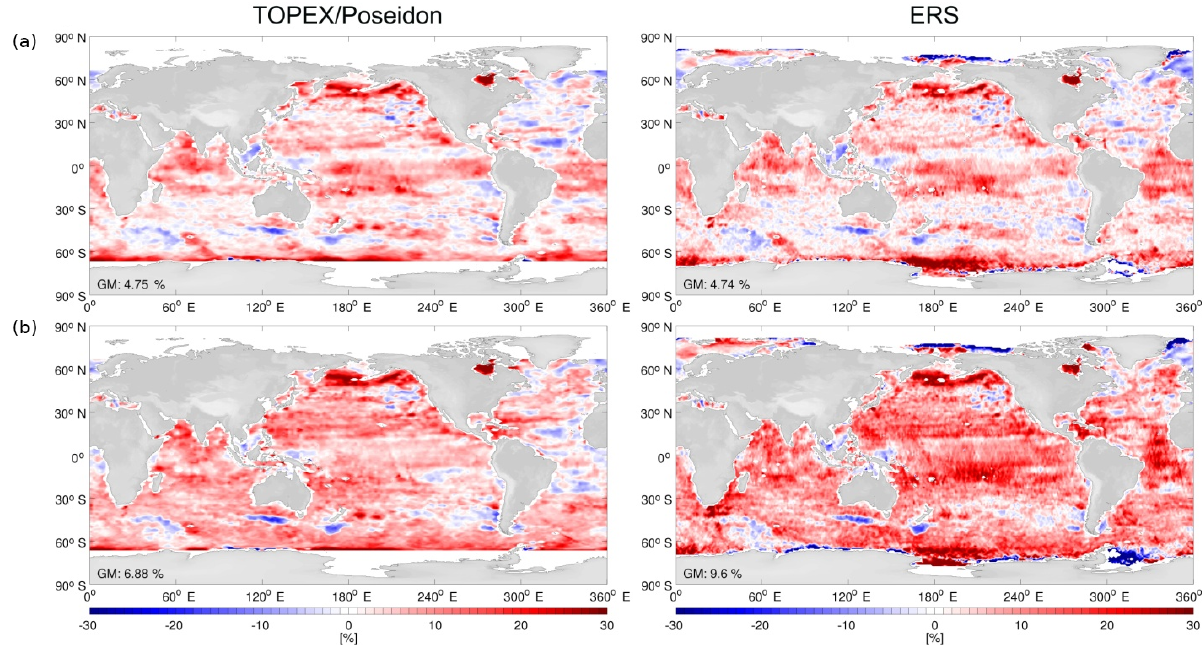
Figure 14. Ratio of RMS differences in low-pass-filtered (f9 or f11) data, for (a) the improvement from DUACS DT2014 (now distributed by CMEMS, previously AVISO) to SL_cci v1.1 as (G0_SL0)/(G1.1_SL1.1), and (b) the total improvement from DUACS DT2014 to SL_cci v2.0 as (G0_SL0)/(G1.1_SL2.0), for TP time series on the left and for ERS time series on the